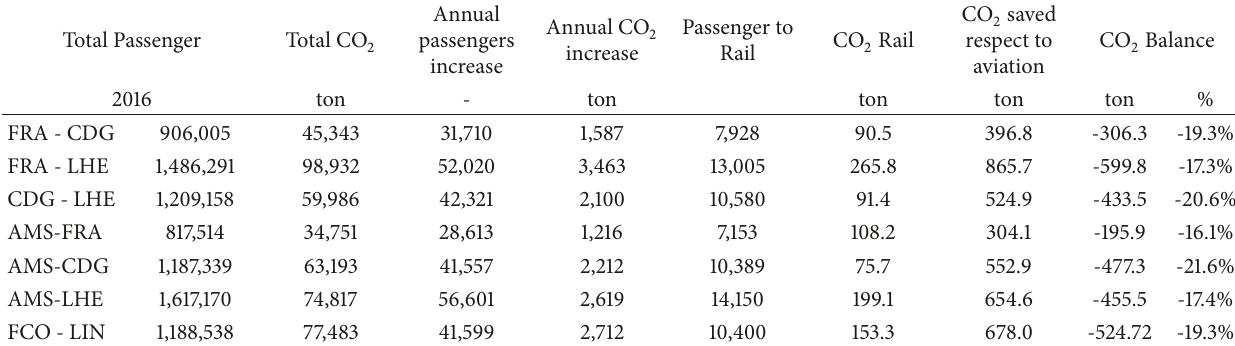
Table 11: High rail scenario with 3.5% annual growth and 25% shifting between the